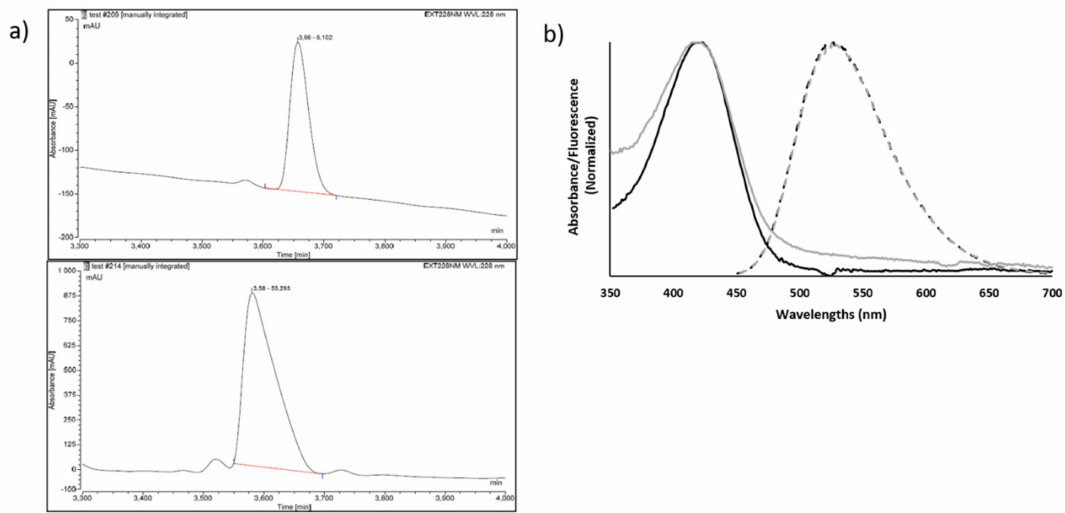
Figure 4. Green-fluorescence labeling of peptide 12 . ( a ) RP-HPLC chromatogram of peptide-alkyne 12 (top) and labeled peptide 13 after 30 min reaction (bottom). ( b ) Normalized absorption (solid line) and emission (dashed line) spectra of azaphthalimide-containing peptide 13 (in black) in the presence of in situ generated copper(I) (grey line) in PBS pH 7.4 at 20 ◦